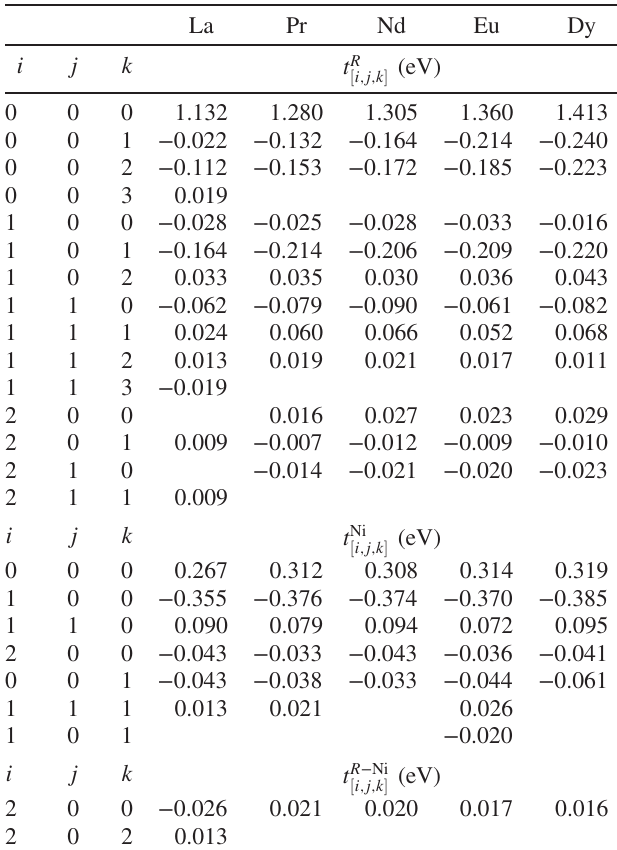
TABLE I. Hopping parameters for two-orbital Wannier down- folding of R NiO 2 ( R ¼ La, Pr, Nd, Eu, and Dy). The hopping terms within Ni or R bands represent the matrix elements as shown in Eqs. (2) and (3). The cross terms represent the matrix P t R − Ni c † R c Ni elements for i 0 ;j 0 ;k 0 ;i;j;k i 0 þ i;j 0 þ j;k 0 þ k + symmetri- i 0 ;j 0 ;k 0 ½ i;j;k (cid:2) cally equivalent terms + H.c. The fractional coordinates are R ¼ ½ 0 . 5 ; 0 . 5 ; 0 . 5 (cid:2) and Ni ¼ ½ 0 ; 0 ; 0 (cid:2) in the paramagnetic unit cell. Hopping parameters for Wannier